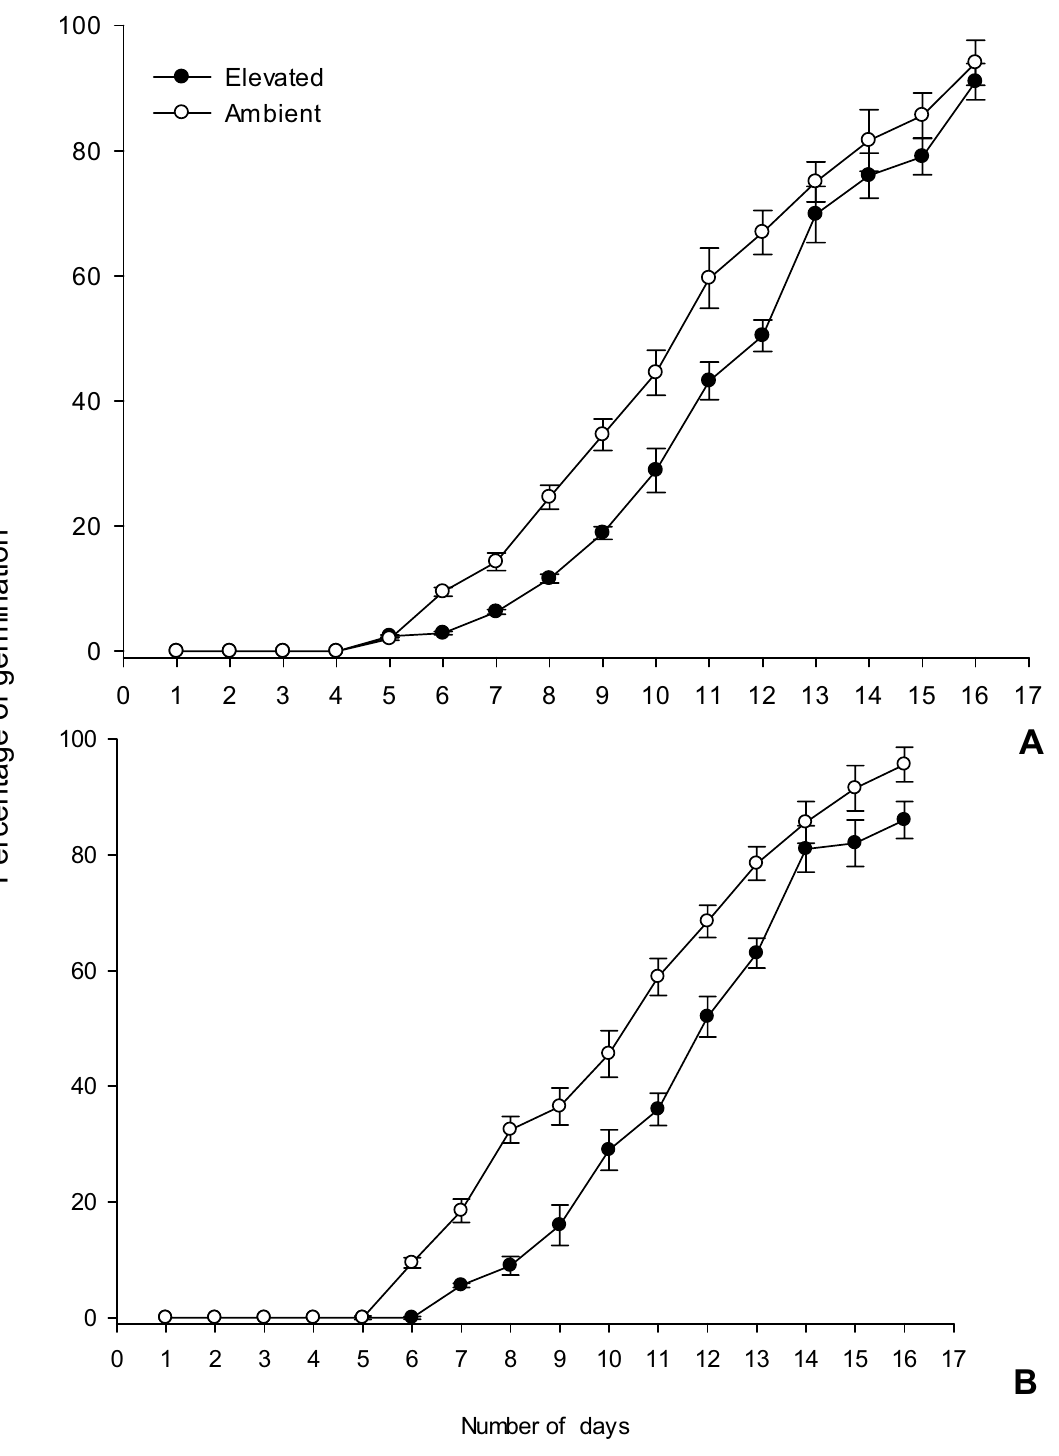
Figure 1. Percentage of different rice seed emergence under ambient and elevated condition. ( A -IR 20; B -ADT